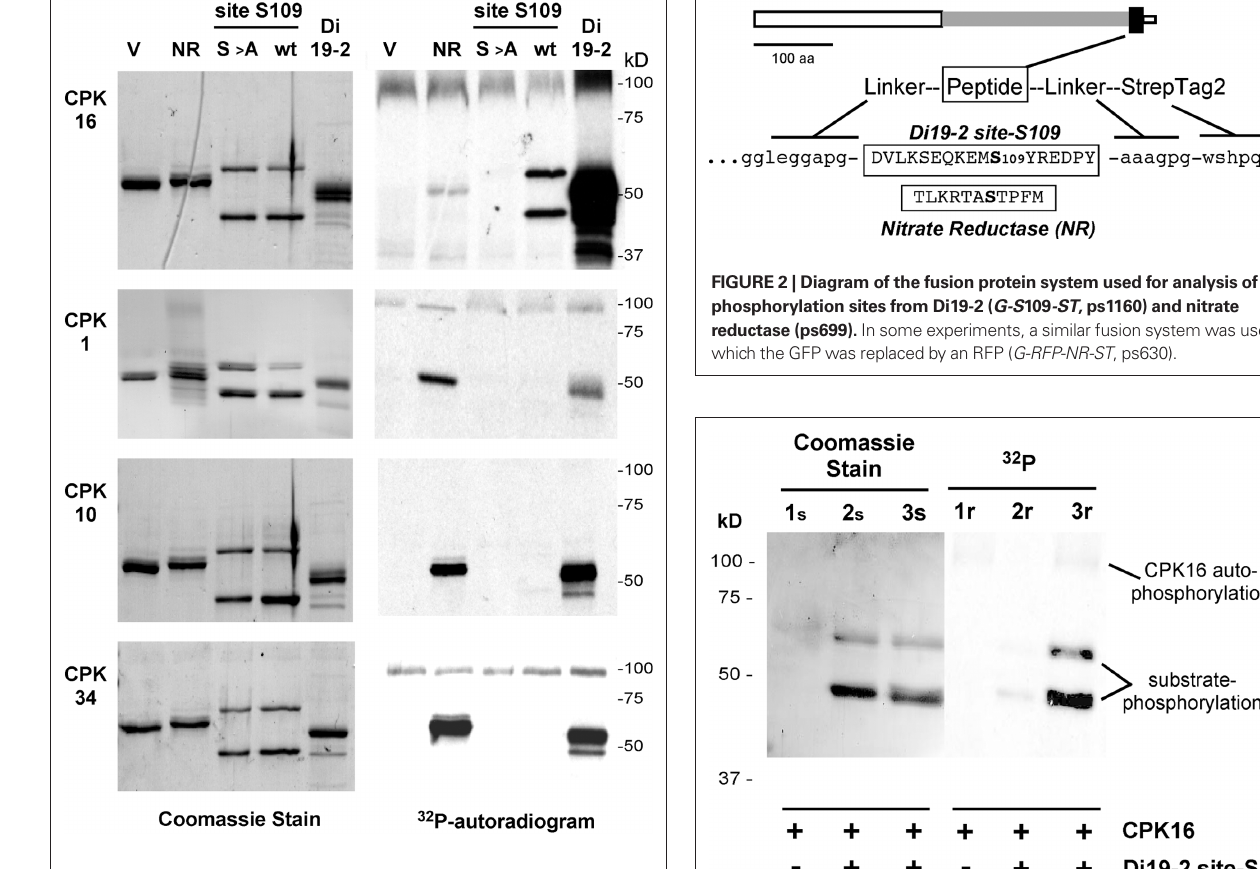
Figure 1 | Kinase reactions showing substrate specificity differences between CPK16 compared to CPK1, 10, and 34. (A) Left side: Coomassie Brilliant Blue-stained gels showing relative loading amounts of substrates for each kinase reaction. (B) Right side: Autoradiogram of stained gel showing proteins labeled by 32 P - phosphorylation. V: GST vector only (ps627), NR: nitrate reductase peptide-GFP fusion ( G-GFP-NR-ST , ps699); S > A: S109A substitution in G - GFP - S 109- ST (ps1256; mutant = DVLKSEQKEMAYREDPY ) ; wt: G-GFP-S 109 -ST (ps1160; wild type = DVLKSEQKEMSYREDPY); Di19-2: Di19-2 full-length GST-fusion protein ( G-Di 19-2, ps1195). Results shown are representative of multiple independent analyses.